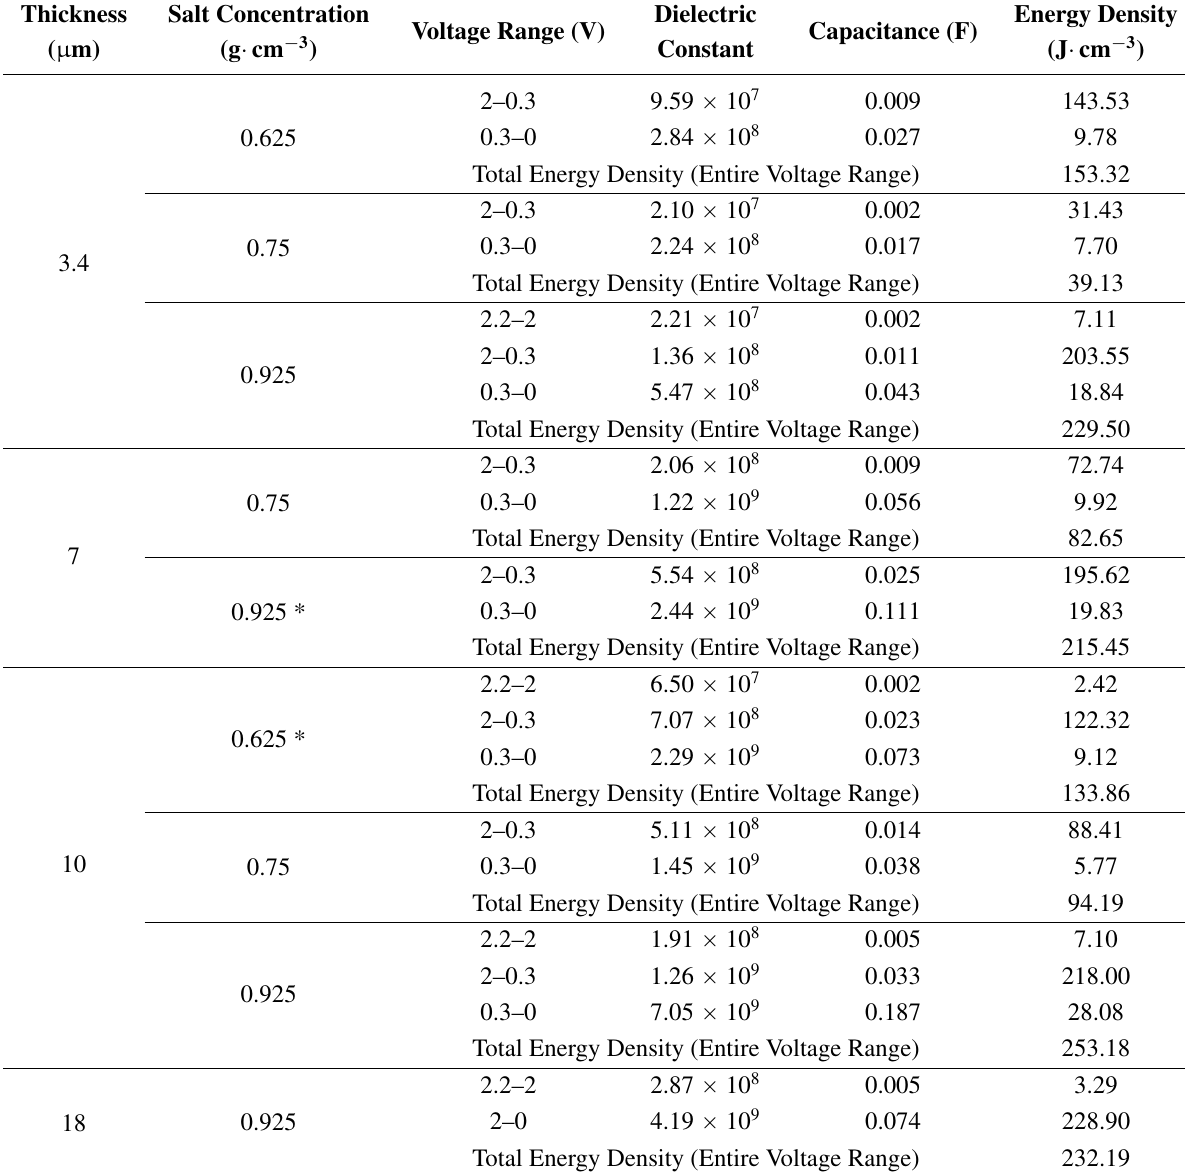
Table 2. Summary of key capacitor parameters and data obtained from nine capacitors generated and